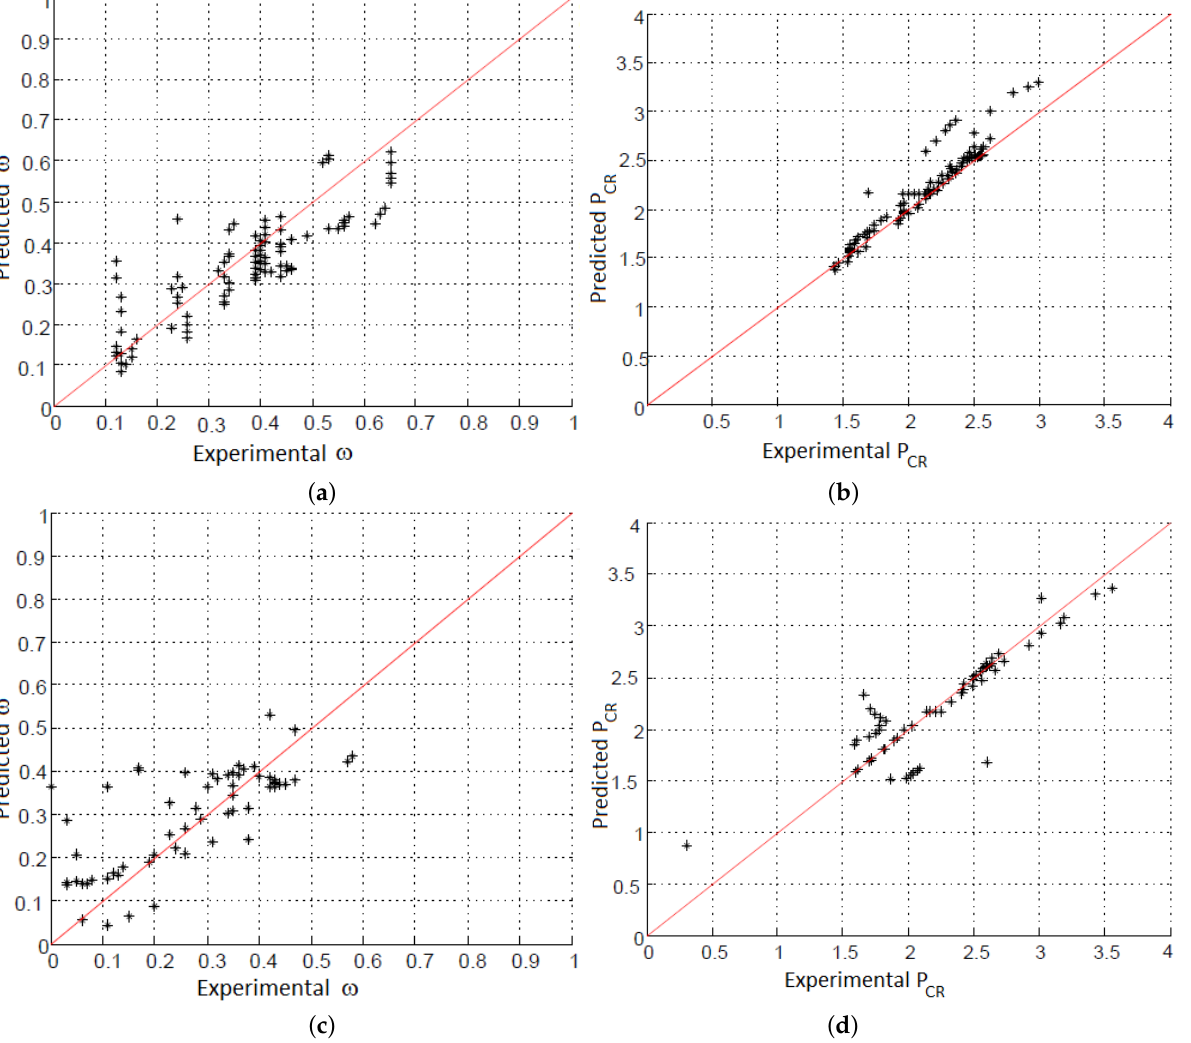
Figure 8. Comparison between the on-design ( a , b ) and off-design ( c , d ) modes in terms of ω ( a , c ) and P CR ( b , d